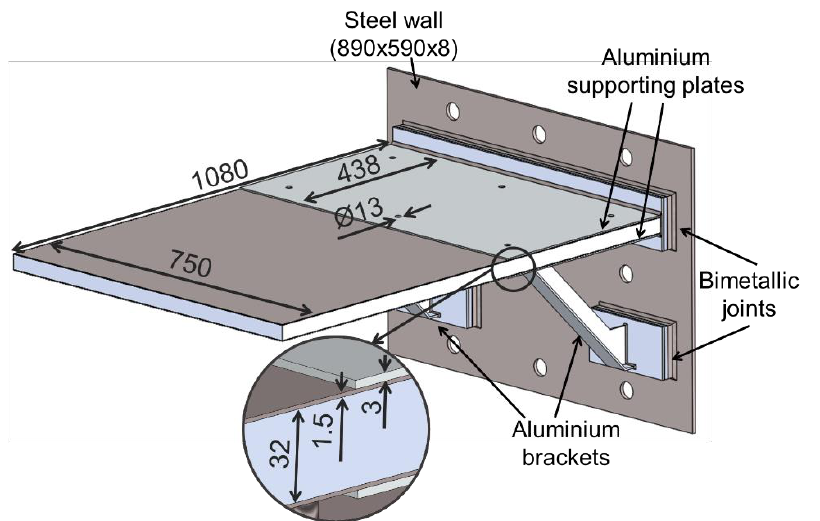
Figure 1. Main features of the balcony overhang.